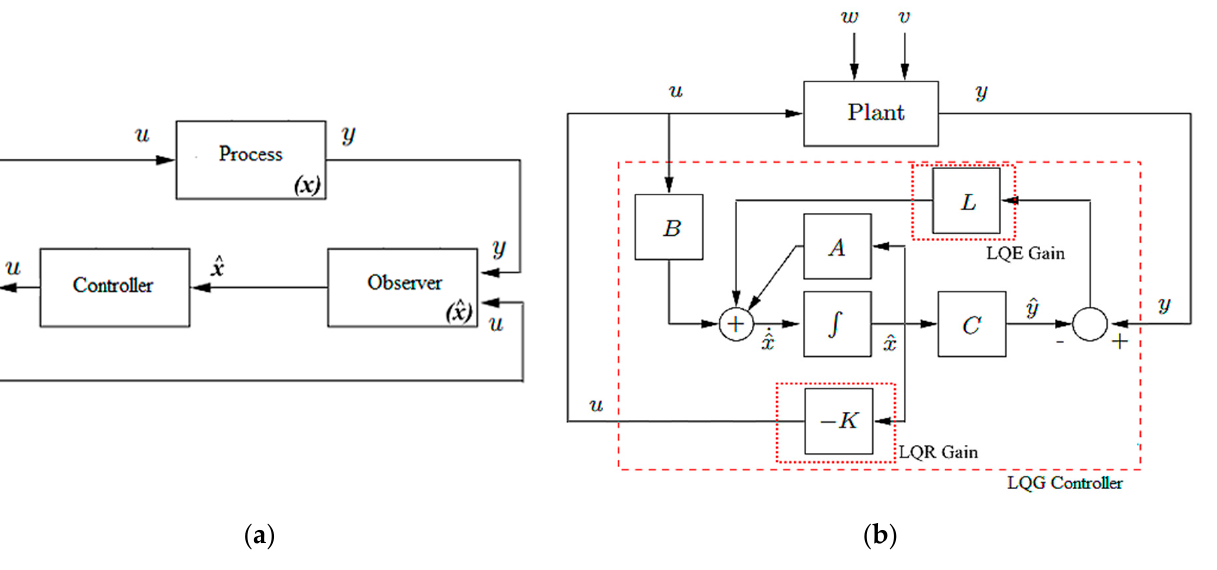
Figure 8 . ( a ) Control strategy of the drill string in the rotary drilling system; ( b ) schematic diagram of designed observer-based LQG.